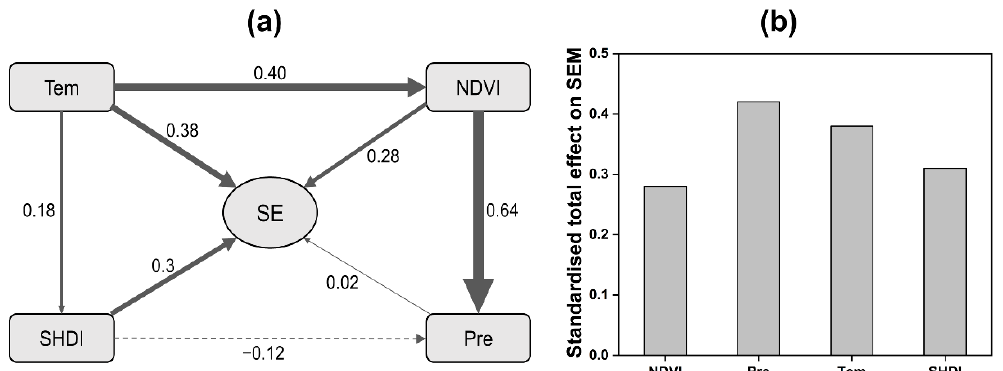
Figure 12. Relationship and contribution of environmental factors to SE. ( a ) Structural equation model of the influence of climate, vegetation, and human activities on SE in CA (the numbers on the arrows are standardized path coefficients, and the width of the arrows indicates the strength of the causal effects). ( b ) Histogram statistics of the contribution degree of each environmental factor to SE. Tem represents temperature, NDVI represents Normalized Difference Vegetation Index, SHDI represents Shannon Diversity Index, and Pre represents precipitation.